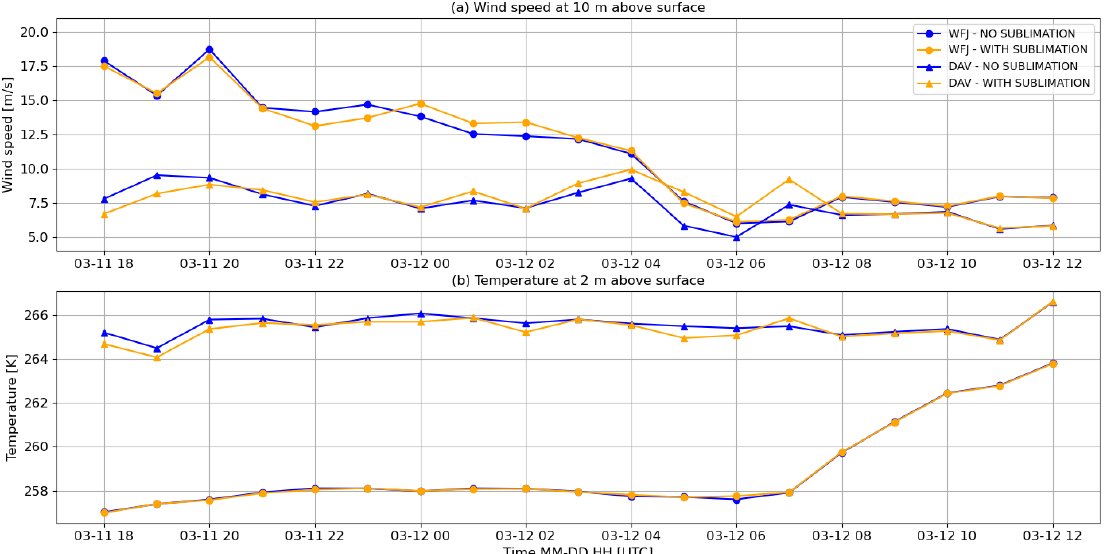
Figure 14. Time series of wind speed and air temperature, as simulated by CRYOWRF at Weissfluhjoch (WFJ) and Davos (DAV), between 11 March 2019 at 18:00UTC and 12 March 2019 at 12:00UTC.